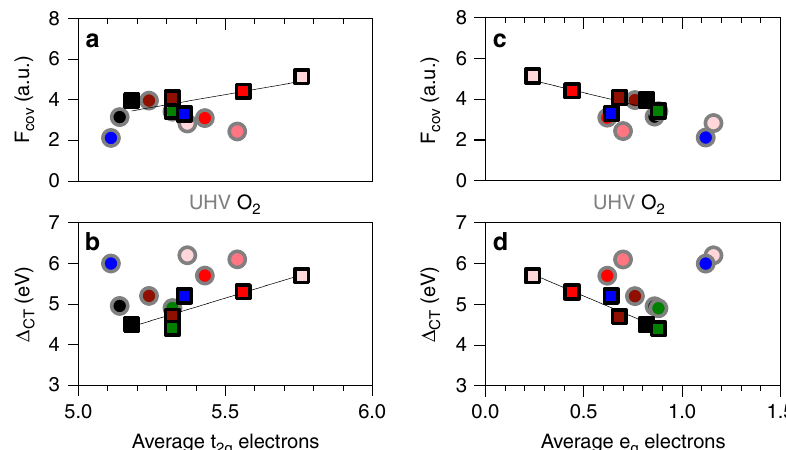
Fig. 3 Intercorrelation of electronic parameters variation of charge-transfer energy and covalency with occupancy. Intercorrelation of electronic parameters variation of charge-transfer energy ( Δ CT *) and covalency ( F cov ) with occupancy of ( a , b ) transition metal (TM) t 2g or ( c , d ) TM e g orbitals. Symbol edge color identi fi es F cov in O 2 presence (black) or ultrahigh vacuum (UHV, gray). Fill colors represent the substituent cation: Ni (green), Zn (blue), increasing Al fraction (dark to light red), and LC (black). Lines represent least squares fi ts of data measured in O 2 presence. Asterisk indicates that the charge-transfer gap was determined as the difference between energies of peak density of states for comparability with previous analysis (Supplementary Note 4). As a result true physical values are smaller than the reported values